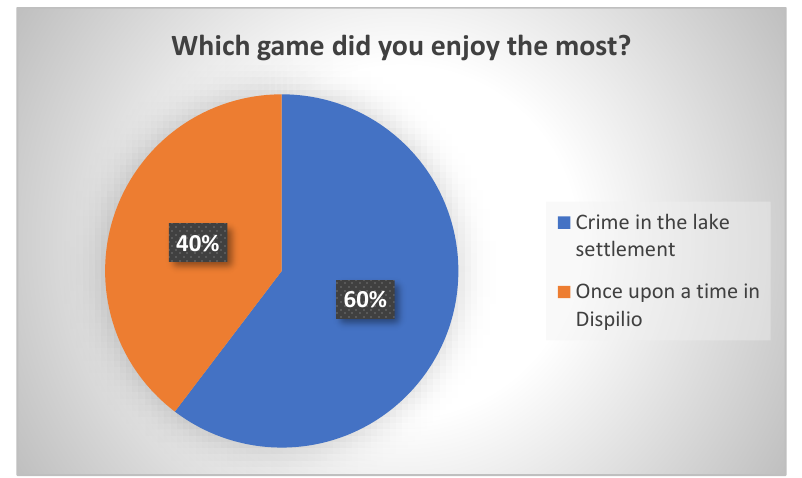
Figure 24. Average scores of the 58 school students.